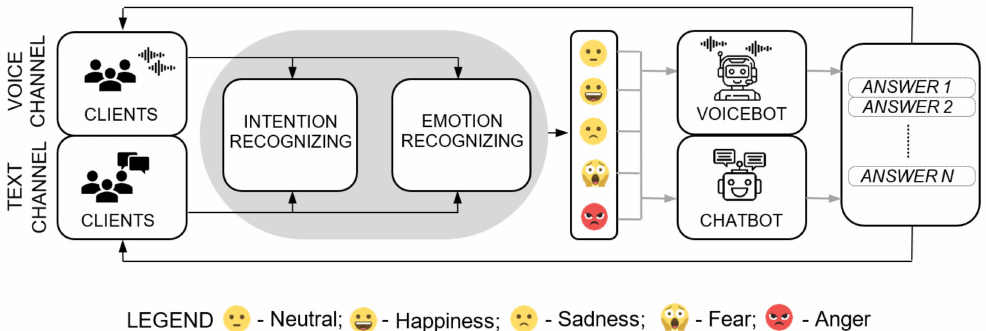
Figure 1. How virtual assistants function taking into account the recognized